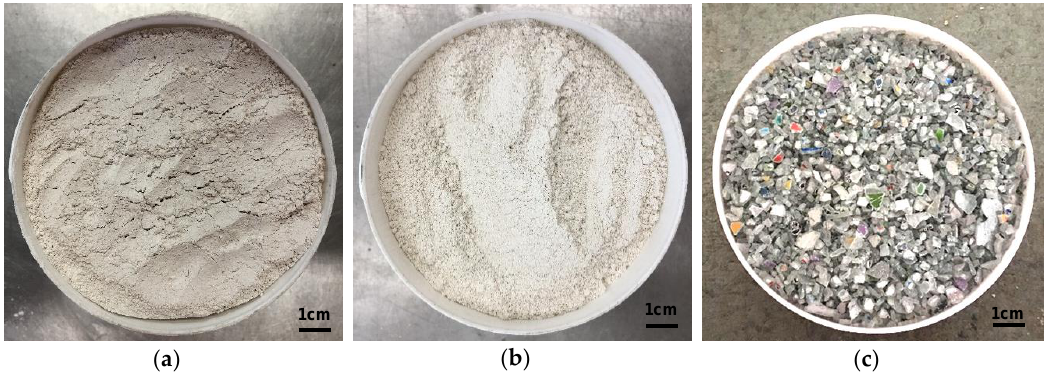
Figure 1. Materials used to develop the new plasters: ( a ) commercial gypsum; ( b ) unheated gypsum waste from plasterboard production; ( c ) polycarbonate waste.